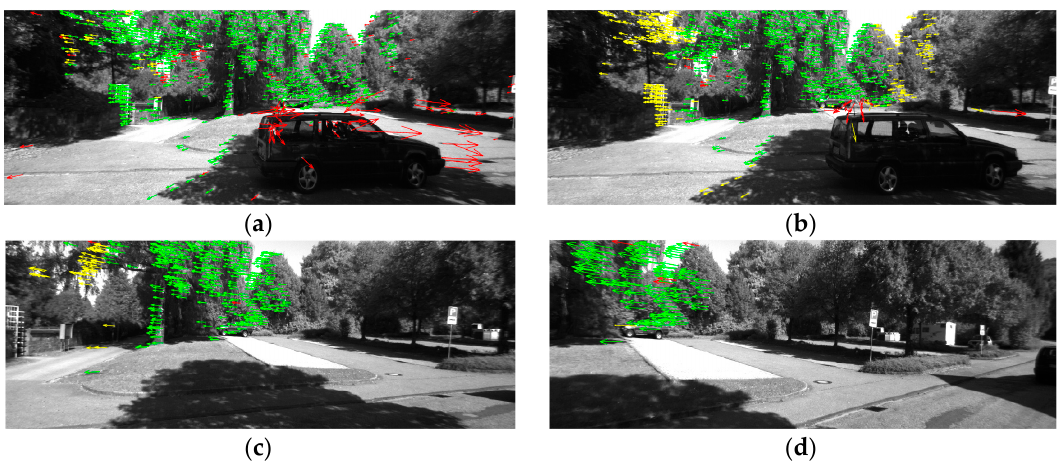
( f ) Figure 5. The results of ego-motion parameter estimation in scenario 1. ( a ) V (cid:2934) ; ( b ) V (cid:2935) ; ( c ) V (cid:2936) ; ( d ) W (cid:2934) ; ( e ) W (cid:2935) ; ( f ) W (cid:2936) . The ego-motion estimation error is expressed by the average translation error (ATE) and the average rotational error (ARE) [23]. The comparison results of PM and WSPC for scenario 1 are shown in Table 2. It can be seen that the PM method is much better than the WSPC method. Table 2. Comparison of ego-motion estimation error in scenario 1. PM